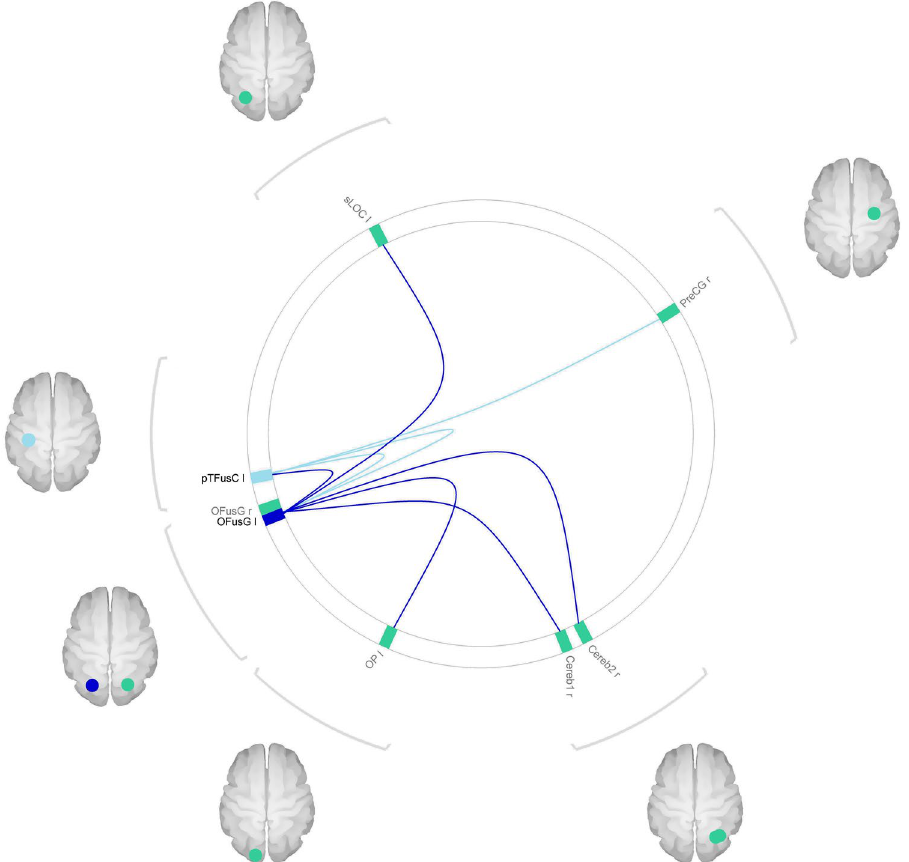
Figure 2. Within-patients effect of the feeding condition on connectivity. The figure shows connections where connectivity was found to be greater in the sated state compared to the fasted state, in patients. Blue circles represent seeds regions; green circles represent target ROIs. The image was generated with the CONN software used for the